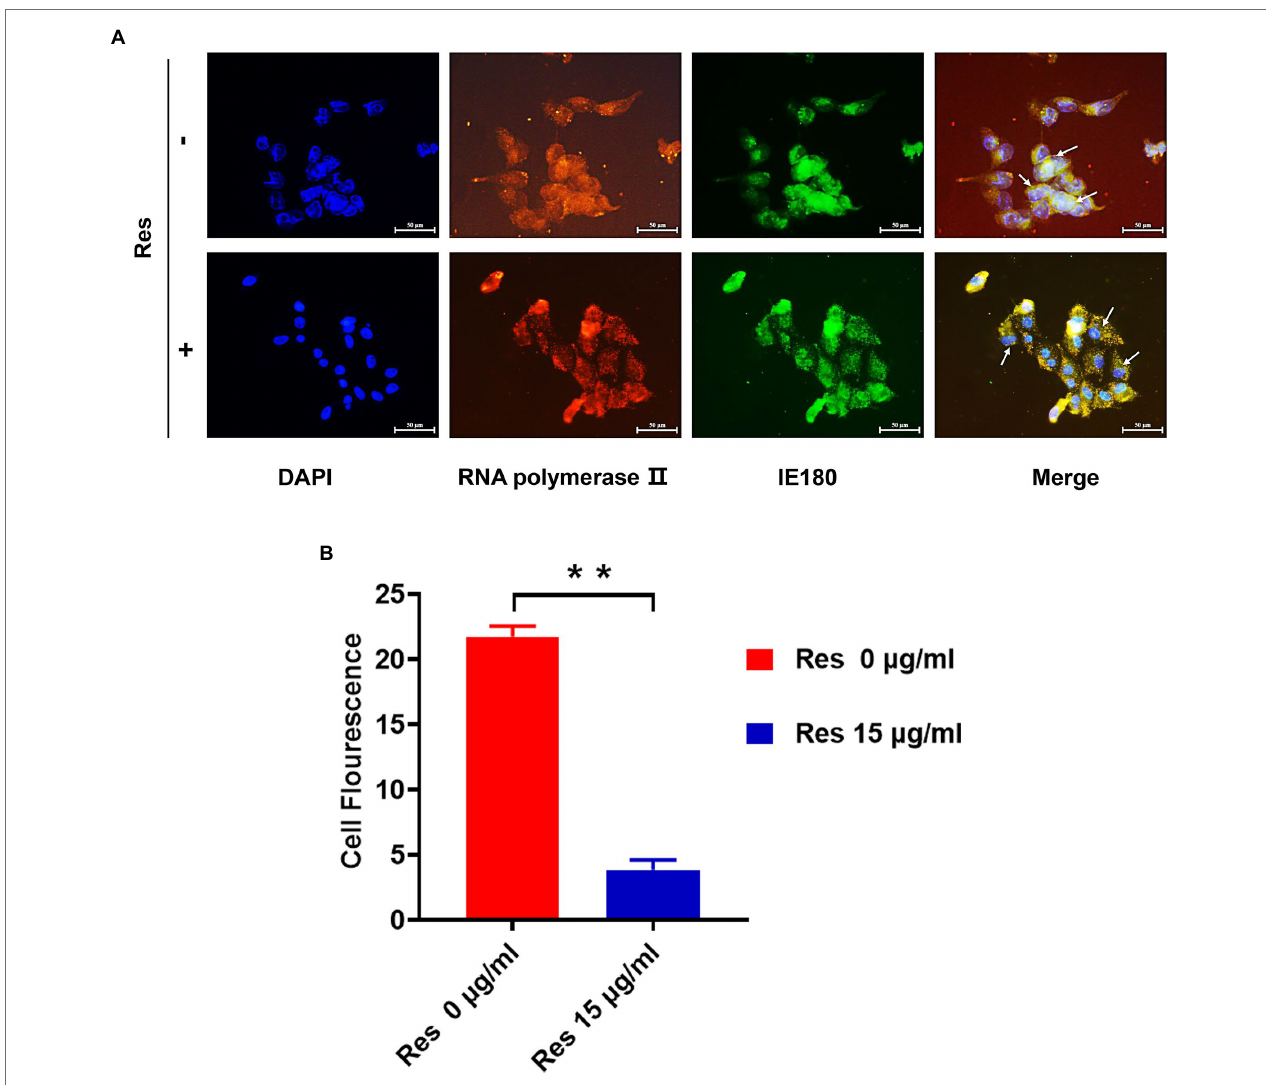
FIGURE 3 | The content of IE180 protein in the nucleus was decreased by Res. (A) The PK-15 cells were infected with PRV (MOI = 5) in the absence or presence of Res (15 μ g/ml). Immunofluorescence was performed using anti-IE180 (green) and anti-RNA polymerase II (red). Nuclei were stained with DAPI. (B) The average fluorescence intensity ratios were calculated, and statistical analysis was performed using the Student’s t -test, ** p < 0.01. Values are means ± SD ( n =